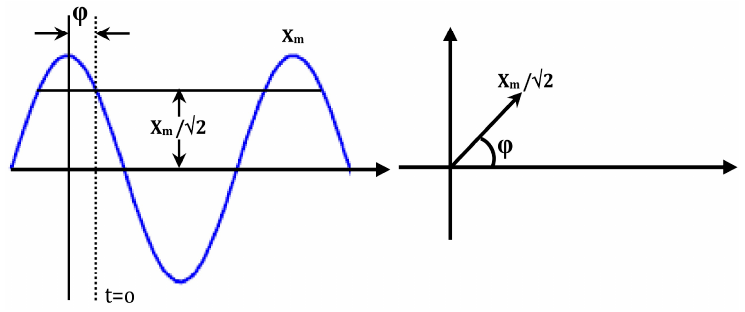
Figure 5. Sinusoidal signal and its phasor